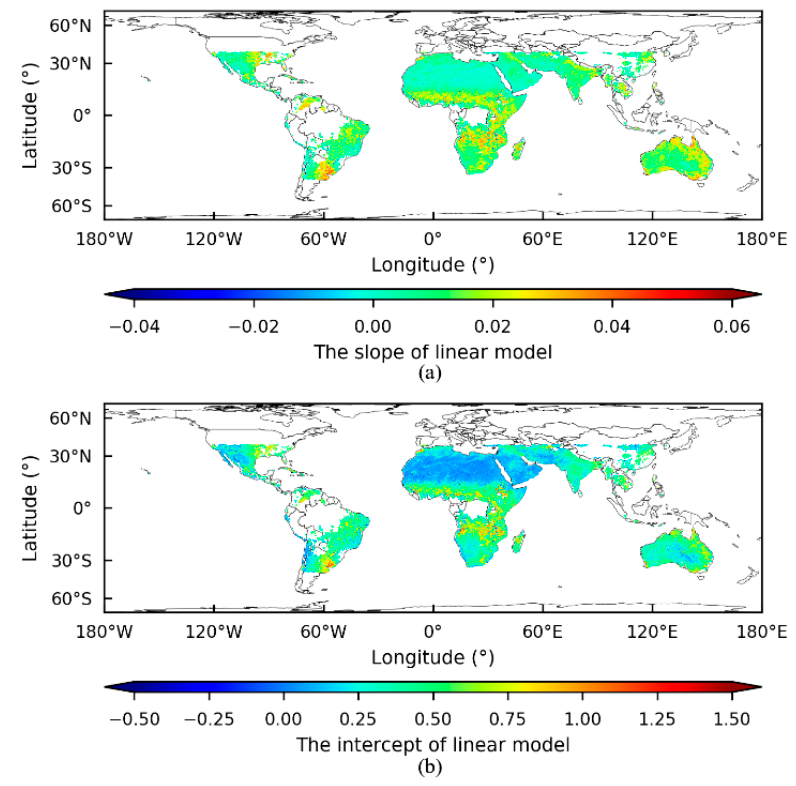
Figure 5. The slope ( a ) and intercept ( b ) of the linear SSM retrieval model.